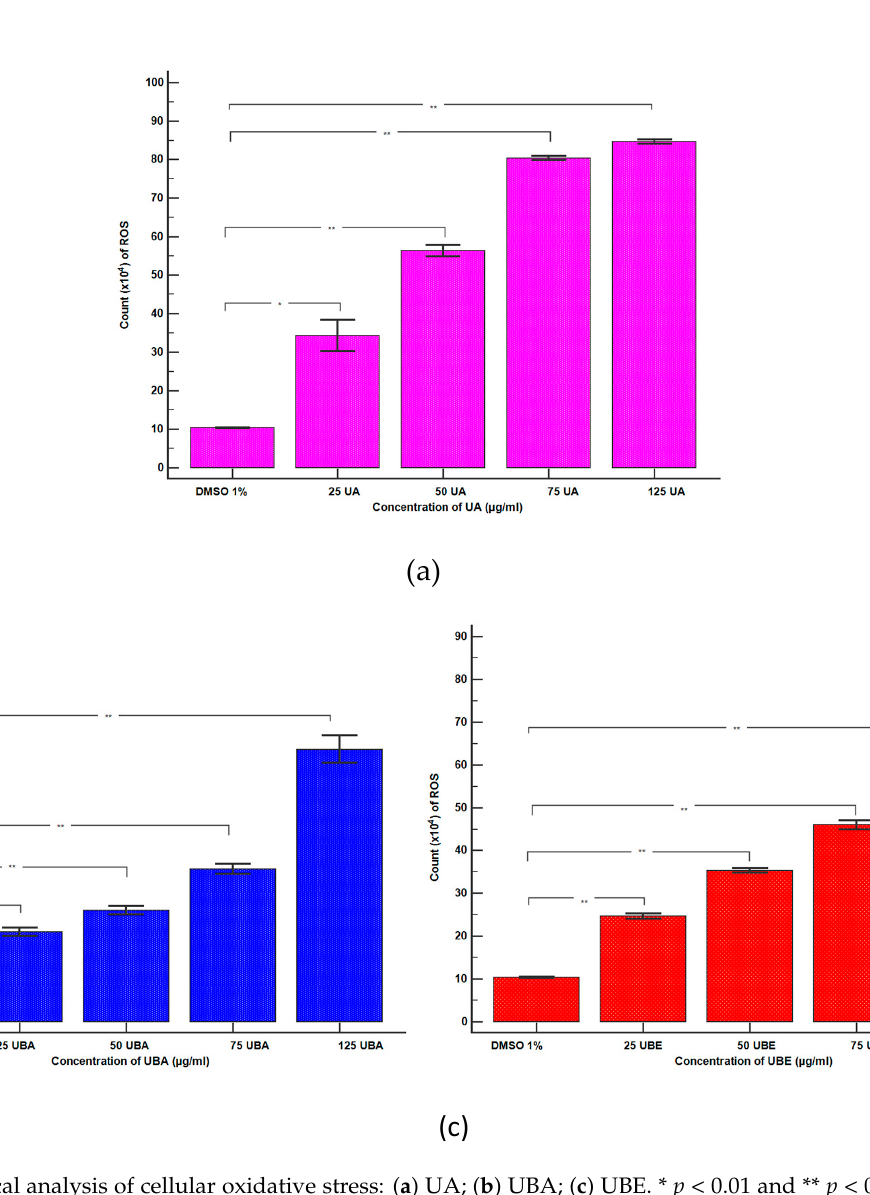
Figure 10. Statistical analysis of cellular oxidative stress: ( a ) UA; ( b ) UBA; ( c ) UBE. * p < 0.01 and ** p < 0.001 represent significant statistical differences between the control and samples made by paired samples t -test.